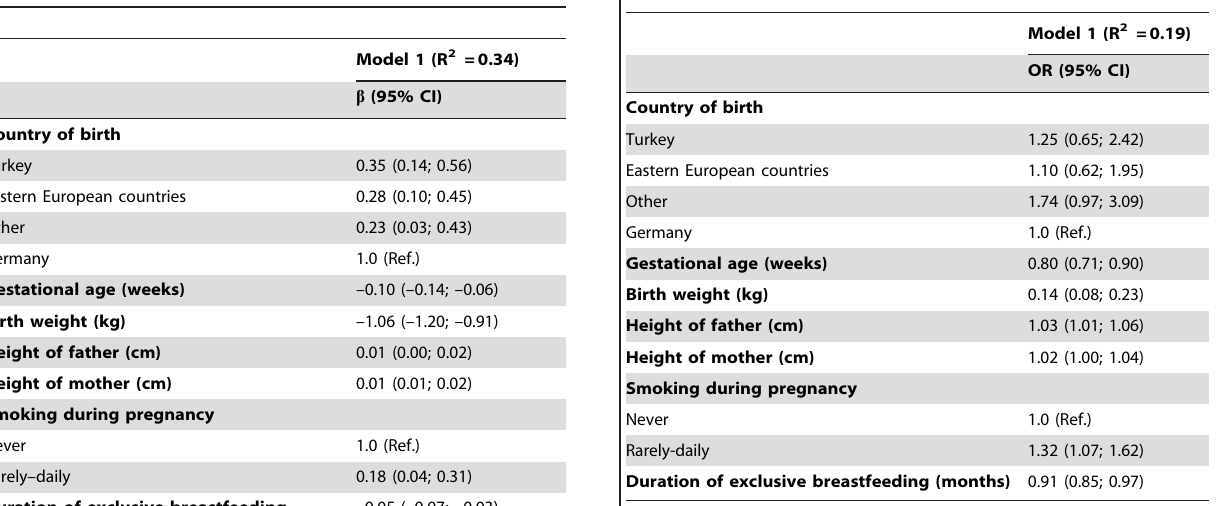
Table 3. Linear regression effect estimates ( b ) for influence of migrant background on infant weight gain (weight z-score) during first six months of life, adjusted for covariates (n=1,031).